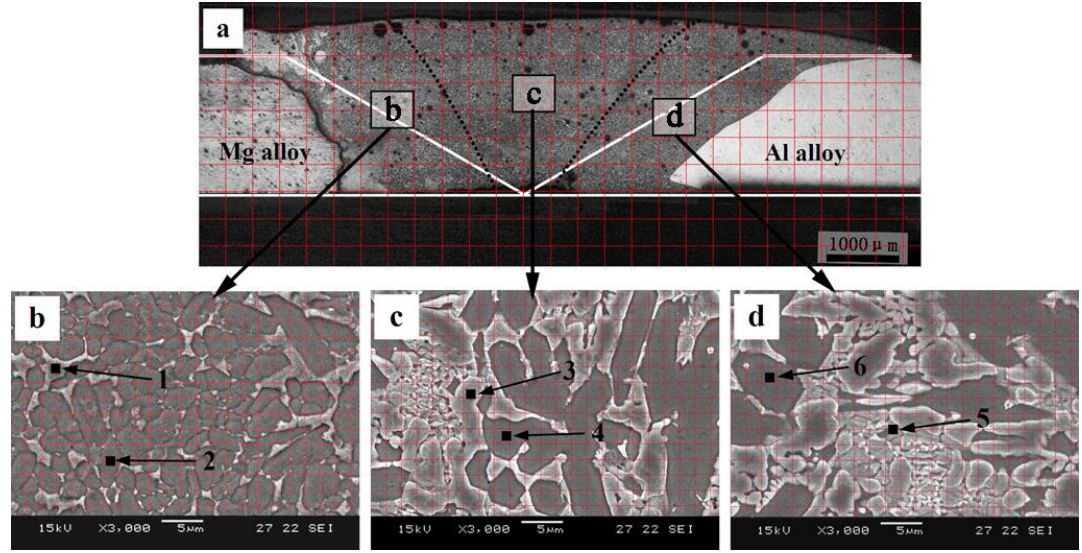
Table 2. The area percentages and compositions of the phases in different locations. Location in Figure